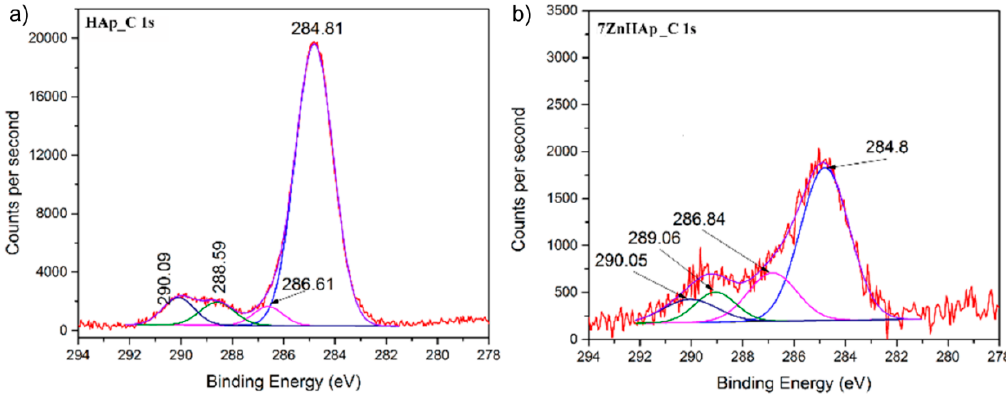
Figure 3. The high-resolution XPS spectra for C 1s of HAp ( a ) and 7ZnHAp ( b ) samples.